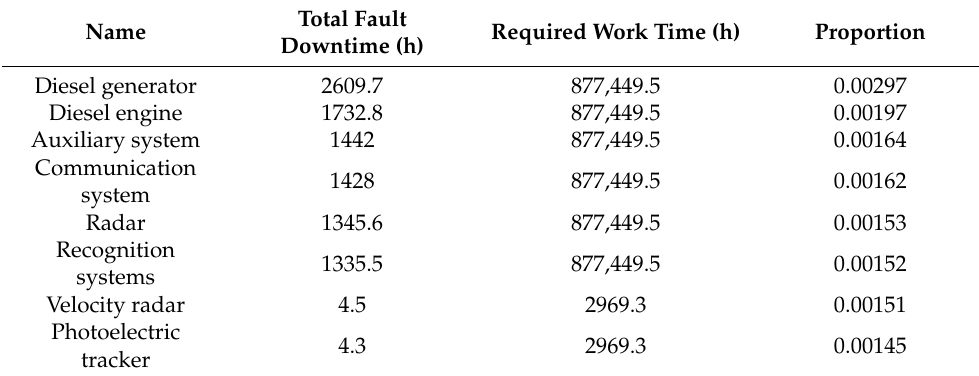
Table 6. The proportion of equipment fault